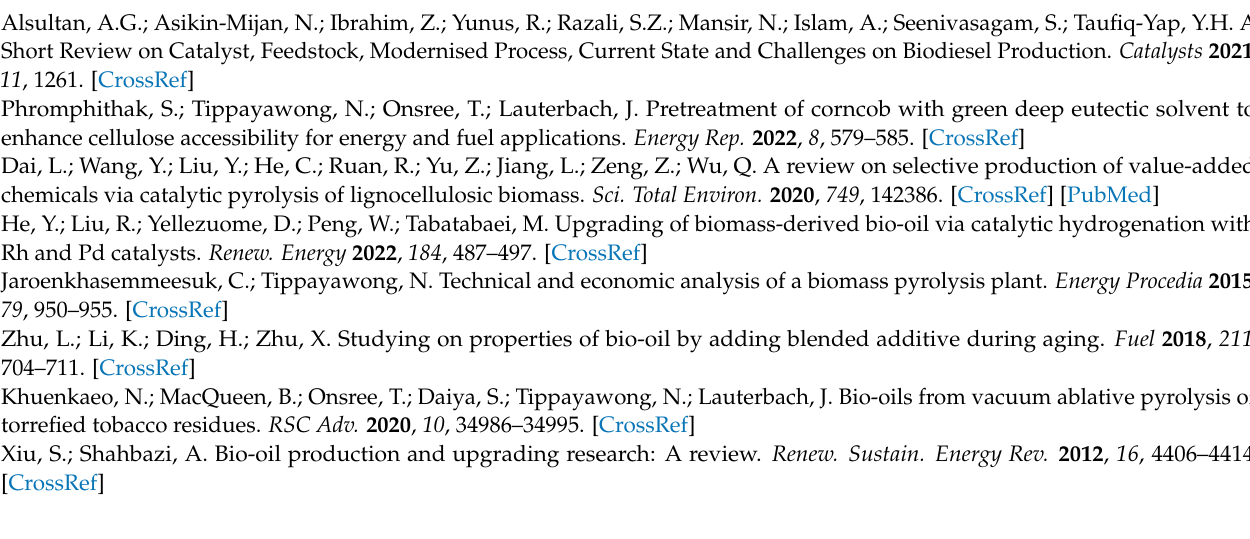
Figure S2: W/A150 diffraction patterns after subtracting the background and silica support signals; Figure S3:15% W/A150: fit to hexagonal WO 3 (ICSD 32001); Figure S4: 10% W/A150: fit to hexagonal WO 3 (ICSD 32001); Figure S5: 5% W/A150: fit to hexagonal WO 3 (ICSD 32001); Table S1: Crystal Structures used to fit the isolated crystallite XRD signals for the WO 3 /A150 samples. Quality of fit (R wp ) values are given for each individual structure’s best fit to each of the W/A150 samples (smaller R wp = better fit)